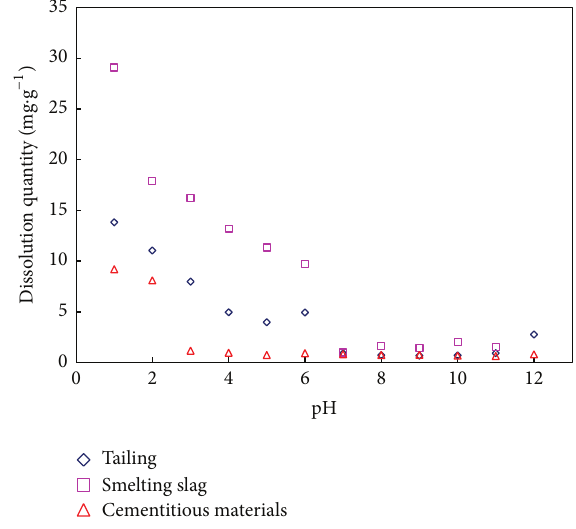
Figure 5: The influence of pH on leaching